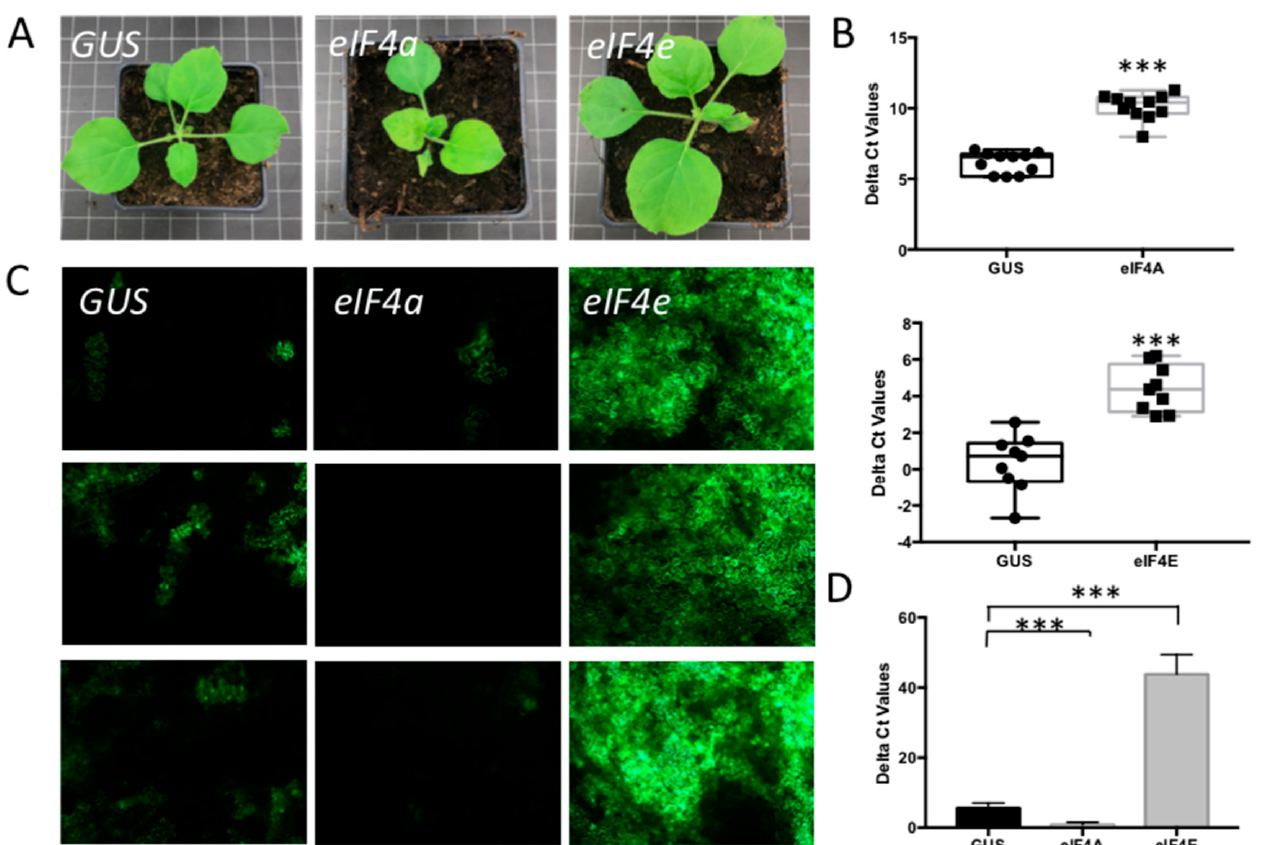
Figure 6. The effect of silencing other SG components on TSWV replication. ( A ) Plant phenotype after VIGS-silencing eIF4A and eIF4E , compared with the GUS -silenced control plant. ( B ) qRT-PCR assay to quantify the silencing efficiency. *** p -value < 0.001. ( C ) Green fluorescence resulting from eGFP expression from a TSWV replicon in plants silenced on SG components, and control plants. Plants were infiltrated with TSWV-eGFP replicon constructs 2.5-week post silencing and harvested at around 60 hpi. ( D ) Statistical analysis of GFP intensity in the silenced plants and control plants.